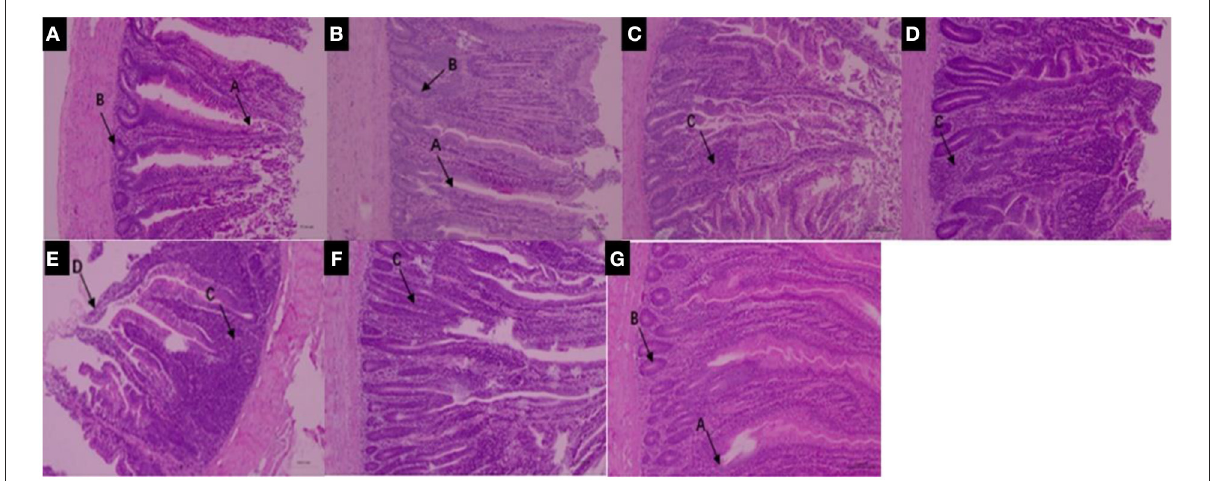
FIGURE4 (A–D) Jejunum structure under 100 × magnification during deltamethrin treatment for 0 (A) , the 1st (B) , 7th (C) , and 14th day (D) . (E–G) Jejunum structure under 100 × magnification at the 1st (E) , 7th (F) , and 14th day (G) during deltamethrin treatment withdrawal. A, intestinal villi; B, intestinal glands (intestinal crypts); C, local mucosal lymphocyte infiltration; D, absence of intestinal villi epithelium.